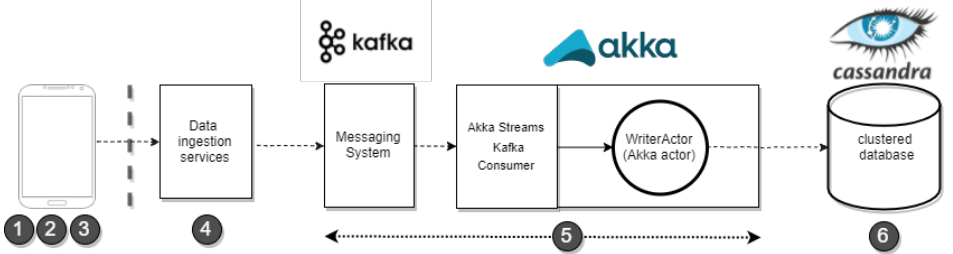
Figure 7. Data flow, implemented tools and involved micro-services in the Data ingestion